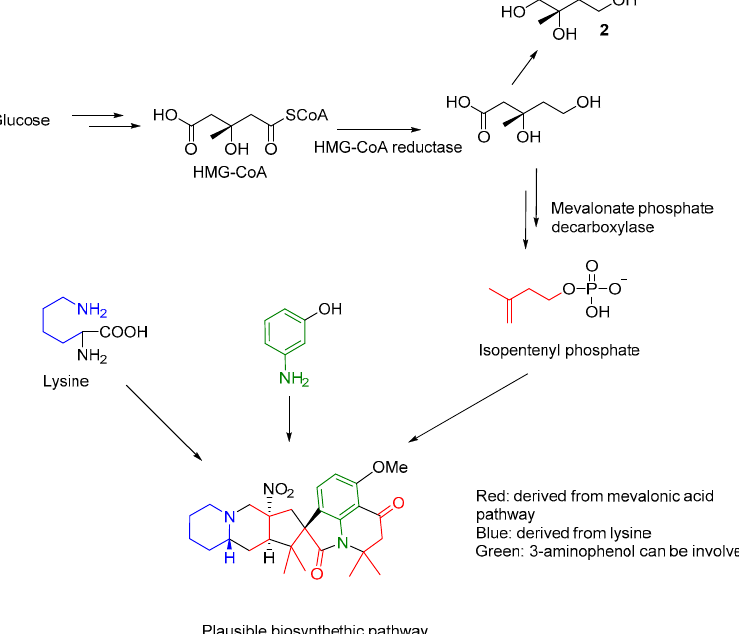
Figure 3. Plausible biosynthetic routes and components of 1. Table 1. NMR spectroscopic data for compounds 1 and 3 .